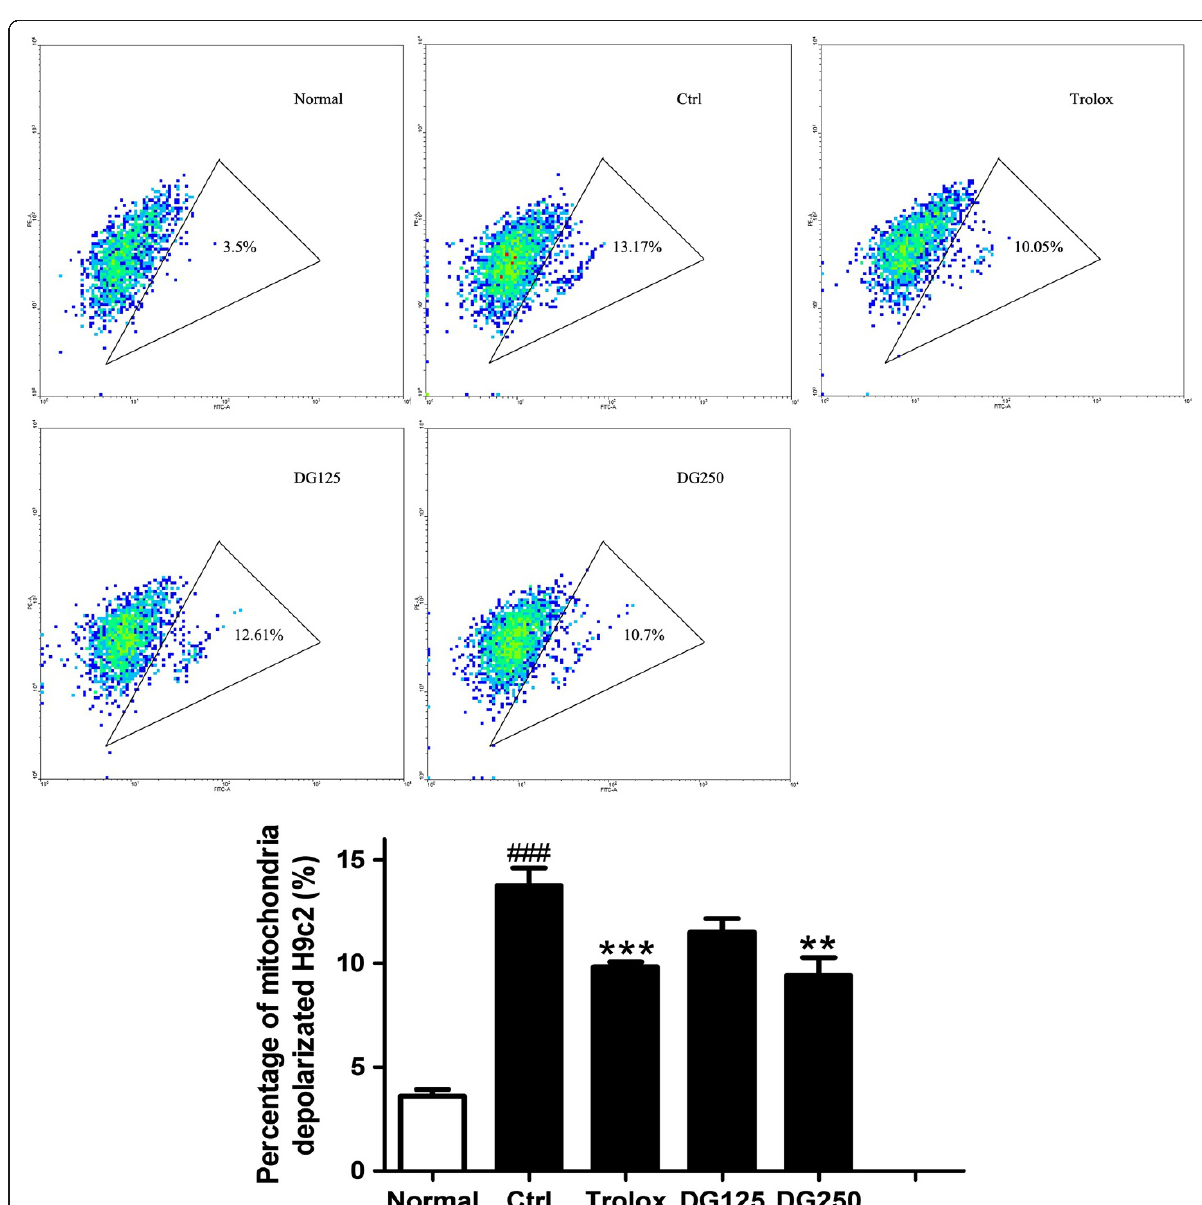
Figure 6 The effect of DG on mitochondrial depolarization in H/R-challenged H9c2 cells. After H/R was challenged in the presence or absence of DG (125 and 250 μ g/ml) or trolox (20 μ M), mitochondrial depolorization was measured by flow cytometry with JC-1 staining. The data were expressed as mean ± S.E.M. Three independent experiments were performed. ### p < 0.001 indicated the groups with significant difference when compared to the normoxic group. **p < 0.01 and ***p < 0.001 when compared to the control